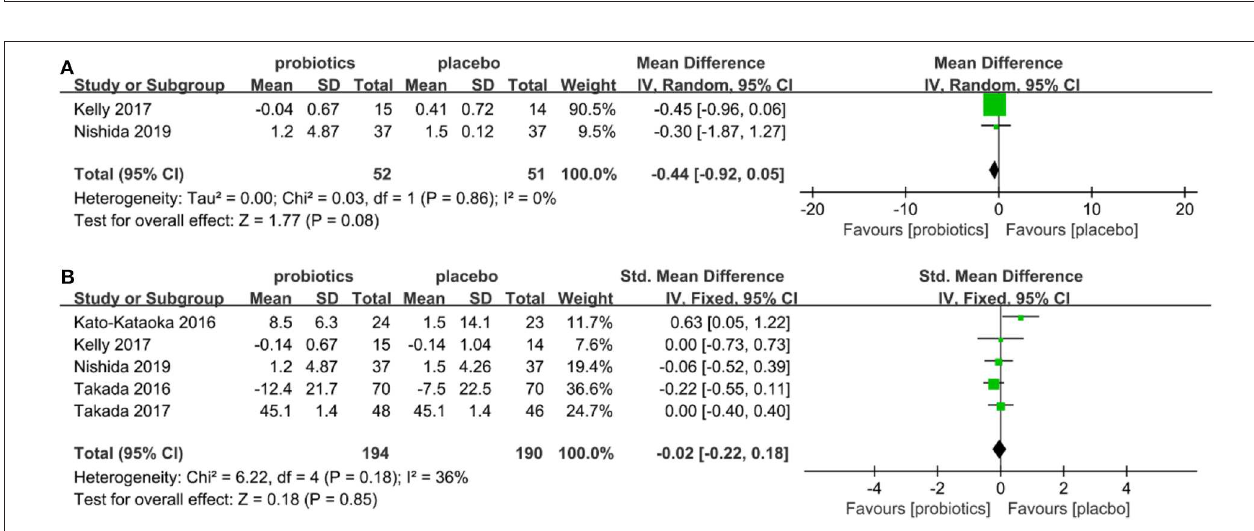
FIGURE 4 | (A) Forest plot showing subgroup analysis of depression in individuals with under stress. (B) Forest plot showing subgroup analysis of anxiety in individuals with under stress.